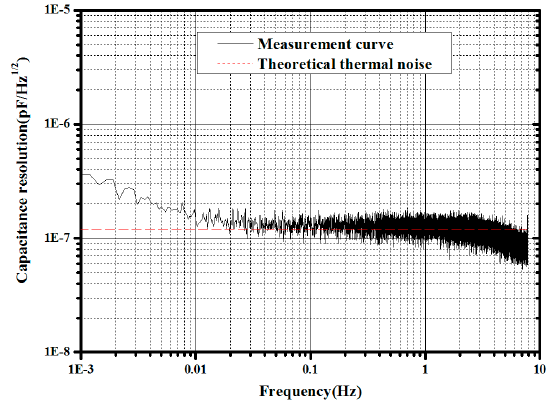
Figure 6. Noise power spectrum density of capacitive transducer.